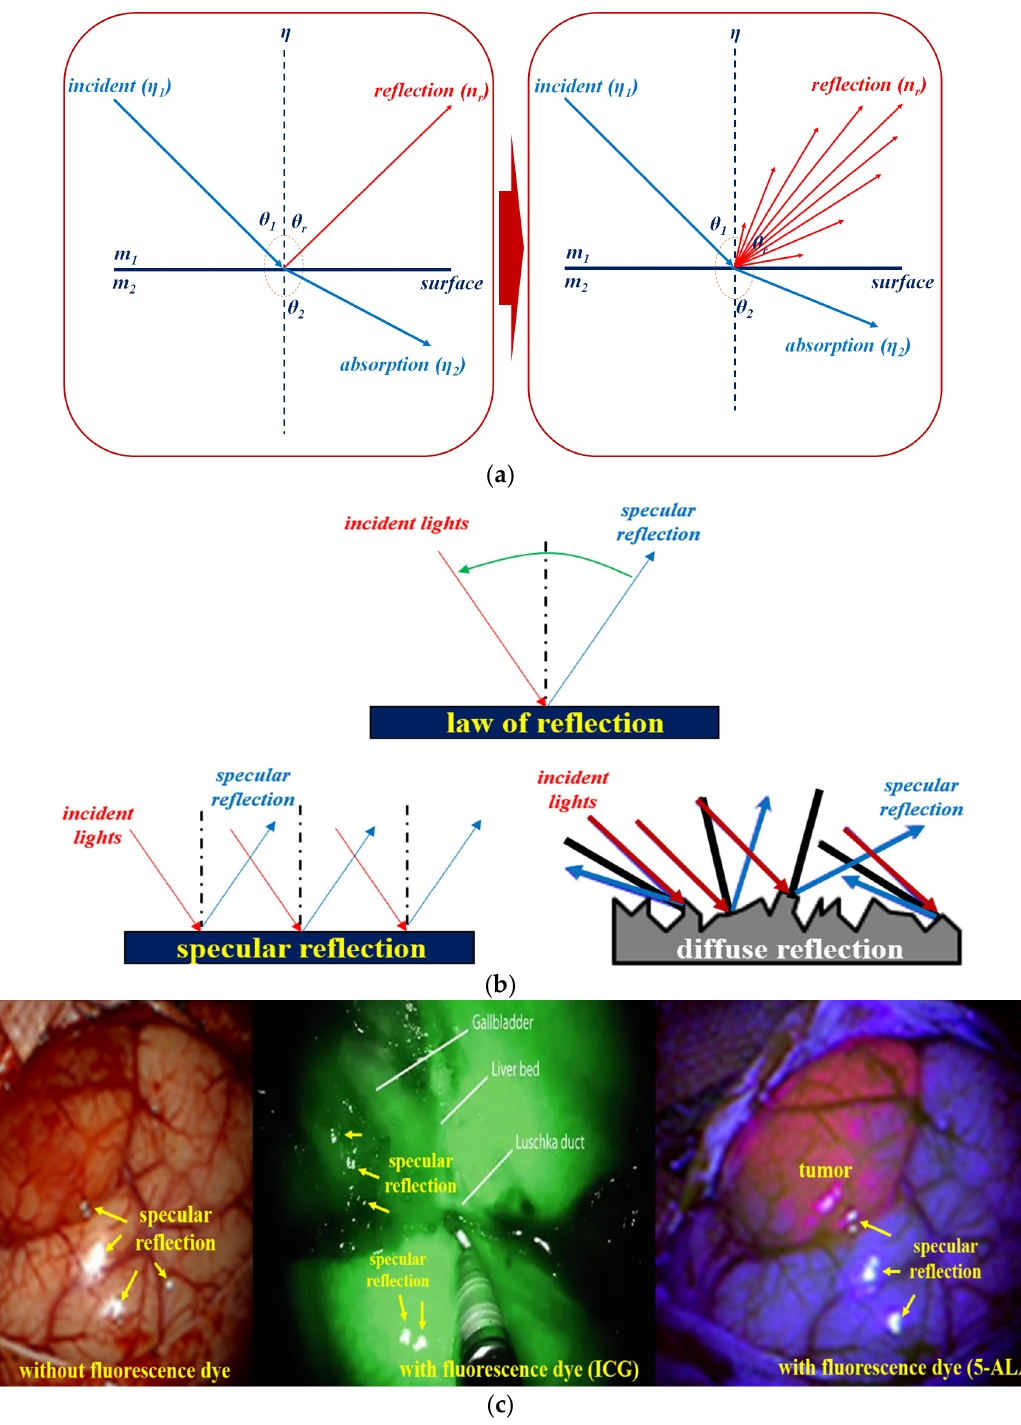
Figure 3. Generation of specular reflection during diagnosis. ( a ) Illustration of Snell’s law. ( b ) Dif- fused reflection resulting from the varying reflected specular ( η r ). ( c ) Comparison among specular reflection observed for cases without the use of a fluorescent dye and that using a fluorescent dye, namely, indocyanine green (ICG) and 5 ‐ Aminolevulinic Acid (5 ‐ ALA). More specifically, according to Snell’s law, light reflection is caused by an incident wave, a transmitted wave, and a reflected wave. At this time, in Figure 4, when light ( η 1 ) incident through the medium (air) of m 1 is transmitted (T) through the medium (tissue) of m 2 , the transmitted light ( η 2 ) is expressed by Equations (1) and (2) As shown, it has a